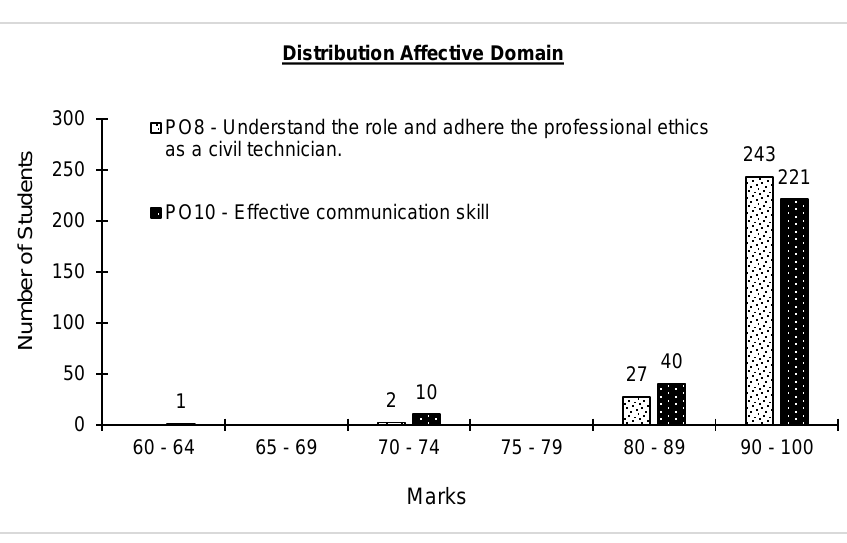
Fig. 2. Distribution of students’ performance of Affective